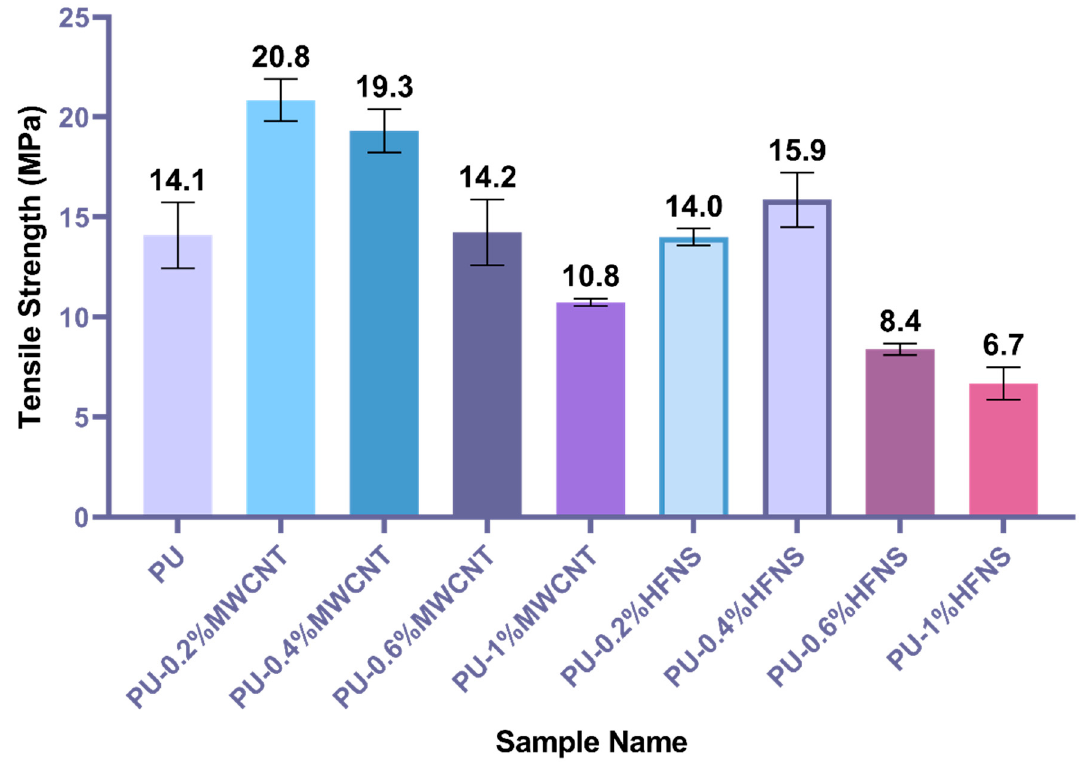
Figure 3. Tensile strength of polyurea and polyurea nanocomposites.